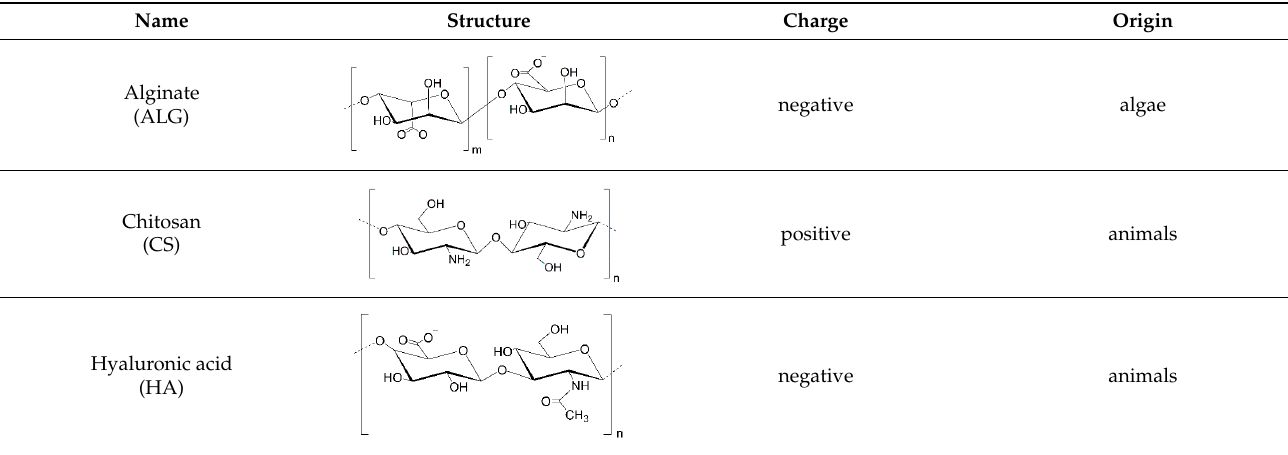
Table 1. Structures and properties of selected polysaccharides.